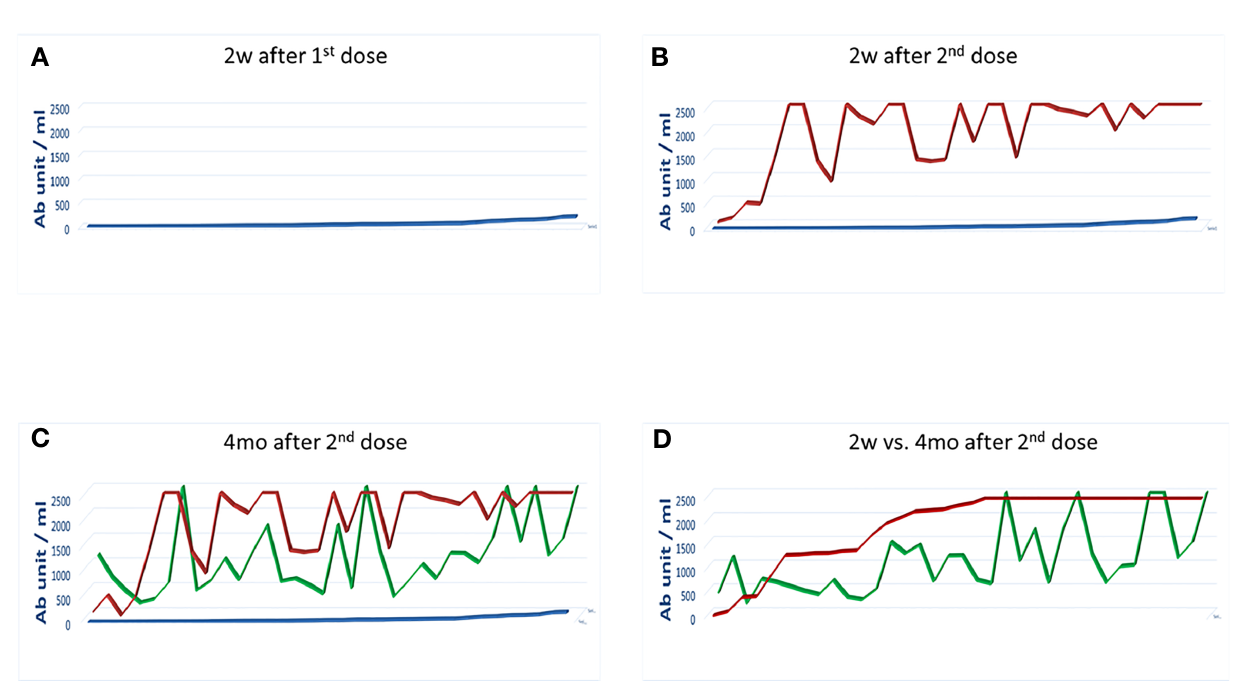
FIGURE 1 | Antibody titers after the 1 st and 2 nd dose of the P fi zer-BioNTech BNT162b2 vaccine. The Ab titer for each vaccinee is shown 2 weeks after the 1 st dose (A) ; 2 weeks (B) and 4 months (C) after the 2 nd dose. The titers at the two time points after the 2 nd dose is shown in (D) . In each panel the blue line: 2 weeks after the 1st dose; the red line: 2 weeks after the 2 nd dose; the green line: 4 months after the 2 nd